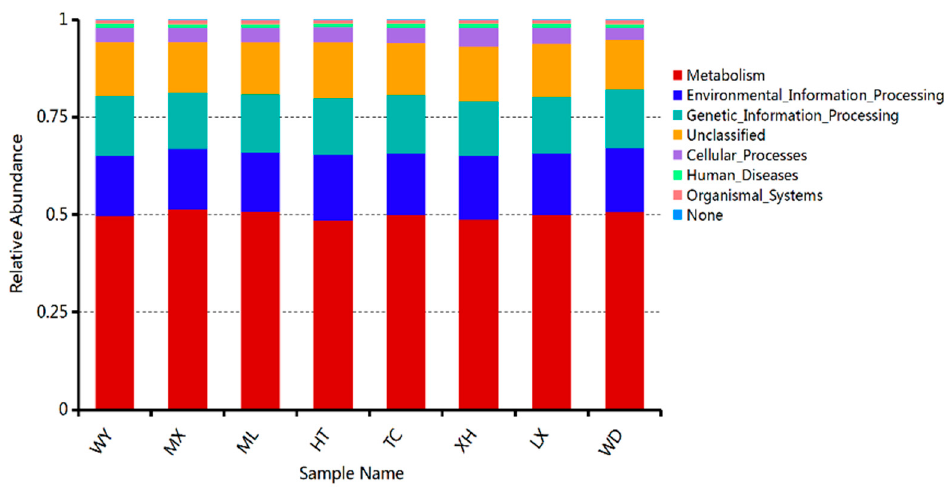
Figure 9. Relative abundance of predicted KEGG Orthologs functional profiles (KEGG level 1) of bacteria.